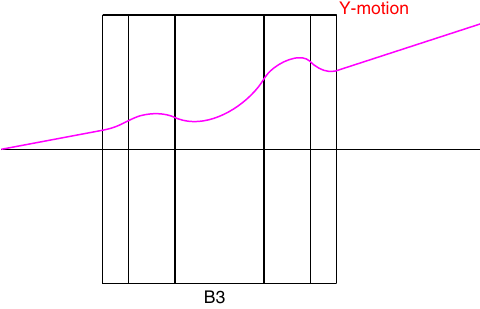
FIG. 7. Out-of-plane ray with an initial angle of 25 mad from sweeper corresponding to an offset of 14.1 cm at the isocenter.